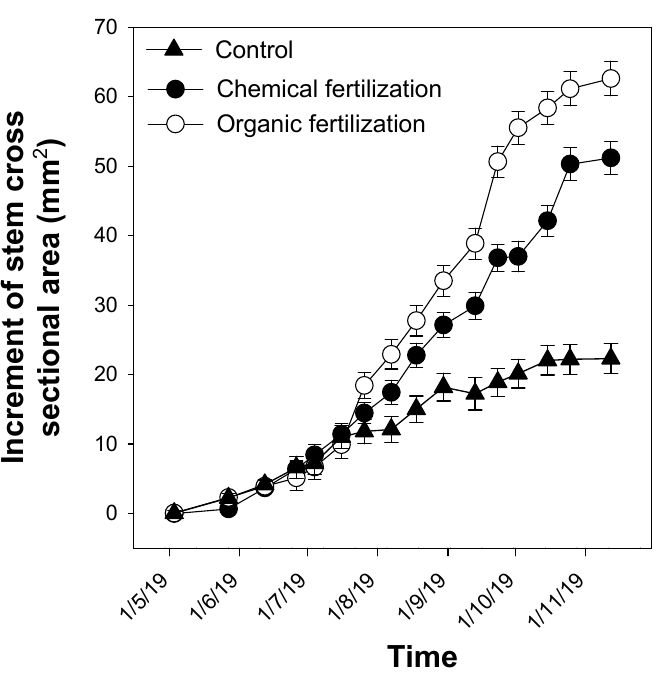
Figure 1. Increment of stem cross sectional area of chemically or organically fertilized potted trees and of unfertilized ones (control) during the vegetative season of 2019. Bars represent standard errors ( n = 6).